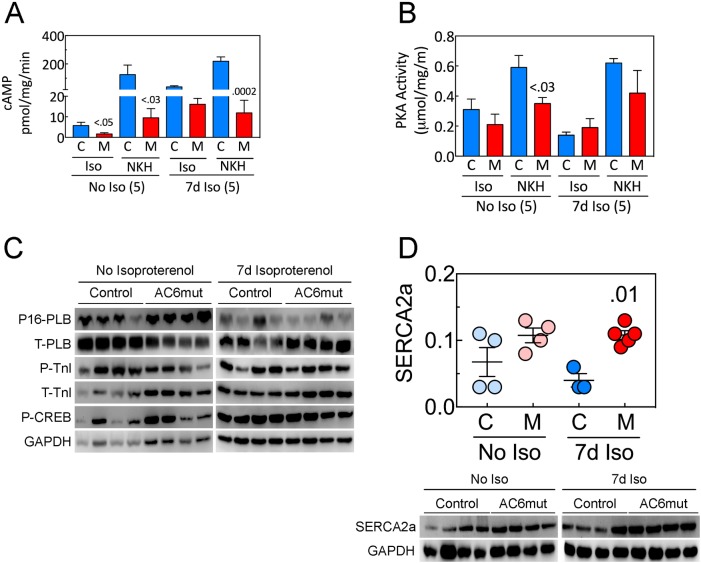
LV cAMP, PKA Activity and Signaling Proteins.A.
Cyclic AMP Generation. LV membranes from AC6mut (M) and control mice (C) were used to measure cAMP production before (No Iso, n = 5) and after 7d isoproterenol infusion (7d Iso, n = 5). Membranes were stimulated with isoproterenol (Iso; 10 μM, 10 min) or NKH477 (NKH, a water-soluble direct AC stimulant; 10 μM, 10 min). Cyclic AMP production was lower in LV from AC6mut than from control mice before and after 7d isoproterenol infusion. B.
PKA Activity in isolated cardiac myocytes before (No Iso, n = 5) and after 7d isoproterenol infusion (7d Iso, n = 5). Cardiac myocytes were stimulated with isoproterenol (Iso; 10 μM, 10 min) or NKH477 (NKH, 10 μM, 10 min). PKA activity (μmol/mg/min) was lower in cardiac myocytes from AC6mut (M) than from control mice (C) before isoproterenol infusion, but no group differences were seen after 7d isoproterenol infusion. C. There was no group difference in total or phosphorylated PLB, total or phosphorylated troponin-I or CREB phosphorylation after 7d of continuous isoproterenol infusion. However, there were pre-Iso group differences in total PLB (reduced in AC6mut, p<0.003), and in P-TnI (reduced in AC6mut, p = 0.005). In these instances, 7d isoproterenol was associated with reduced levels in the control animals, such that there no longer were group differences. D. LV SERCA2a protein showed group differences (2-Way ANOVA: Interaction: p = 0.29; Iso: p = 0.44; Gene: p = 0.002). Seven days Iso increased LV SERCA2a in AC6mut (M) mice vs control (p = 0.01). In A and B, P values from Student’s t-test (unpaired, 2-tailed); In D, p value from 2-way followed by Sidak’s multiple comparison test. In all Figures displaying immunoblotting, summary data are normalized to GAPDH.